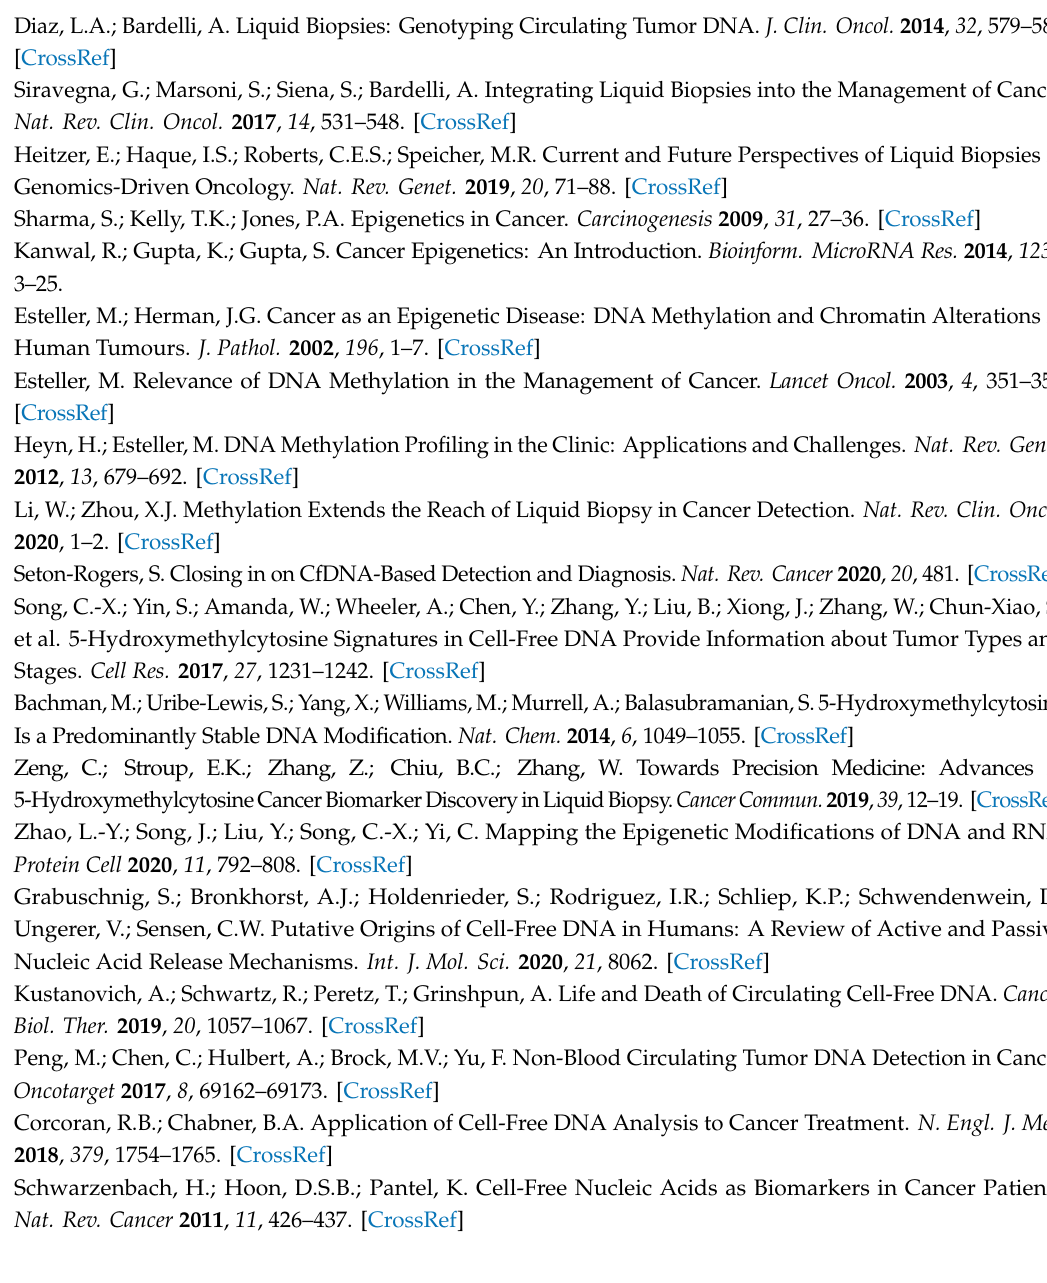
Table S1. Summary of the analytical workflows of the assays for the evaluation of DNA-methylation from cell-free DNA samples classified by DNA treatment (blue), library preparation (yellow), amplification (grey) and analysis (orange)